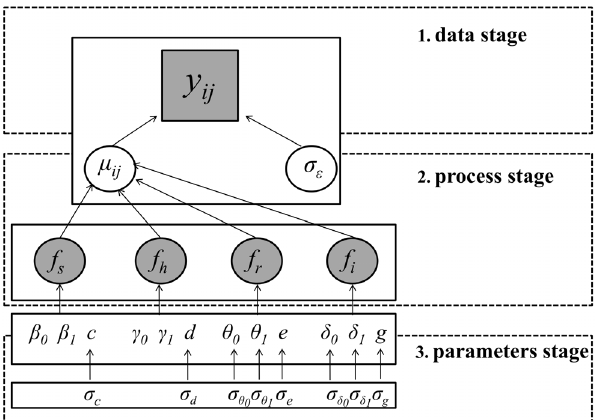
Figure 2. Directed Acyclic Graph showing how Acropora cover y ij at a site i and time j is fitted in three stages. Here, the transformed data y ij are modelled using a normal distribution with an expected value m ij and variance s e . The expected value m ij is a function of four spatial scales (sub-region f s , habitat f h , reef f r , and site f i ). Linear trends at sub-region and habitat scale are modelled using fixed effects ( b , c ). At the site and reef scale, trend parameters ( h , d ) are considered as random. Trend parameters are denoted with the subscript 0 corresponding to the intercept and 1 corresponding to the slope. Random effects require specification of a variance component ( s ), specified for each spatial scale of the model. Refer to the